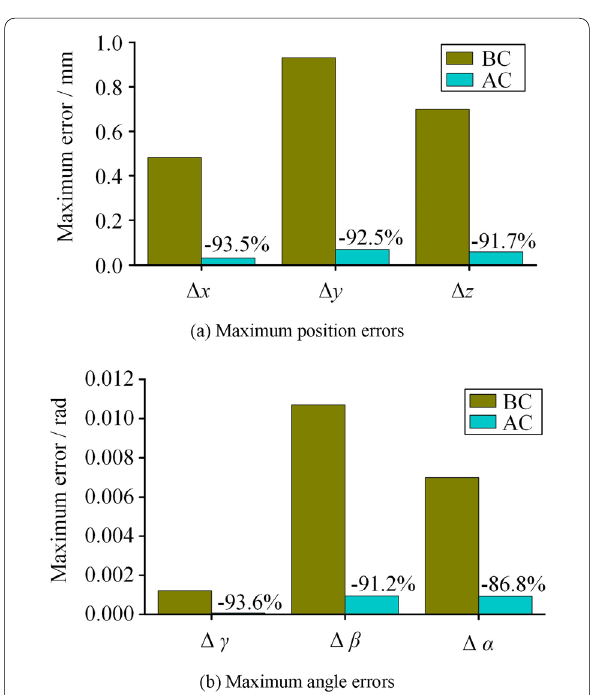
Figure 5 Comparison of posture errors before and after calibration (BC, before calibration; AC, after